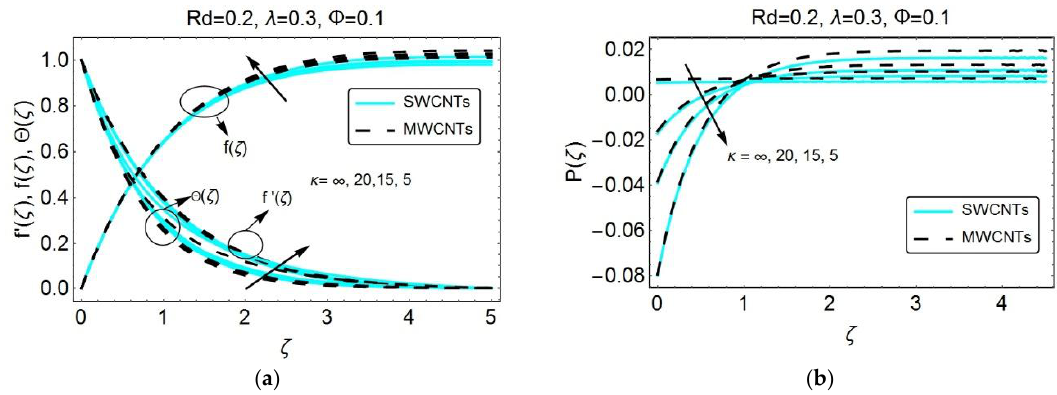
Figure 2. ( a ) 𝑓(𝜁) , 𝑓 ′ (𝜁) and Θ(𝜁) ; and ( b ) 𝑃(𝜁) for some values of 𝜅. Figure 2. ( a ) f ( ζ ) , f (cid:48) ( ζ ) and Θ ( ζ ) ; and ( b ) P ( ζ ) for some values of κ